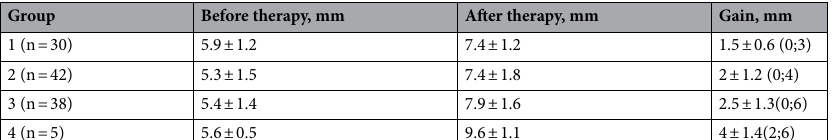
Group Before therapy, mm After therapy,